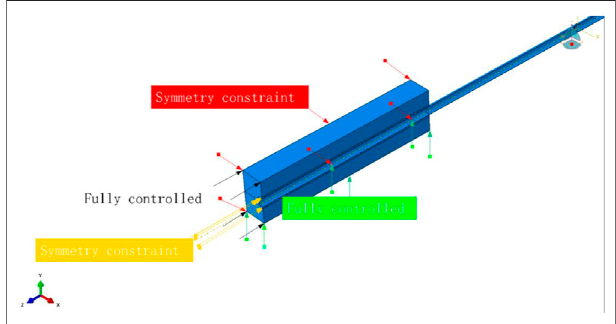
FIGURE 3 | Pipe – soil boundary conditions